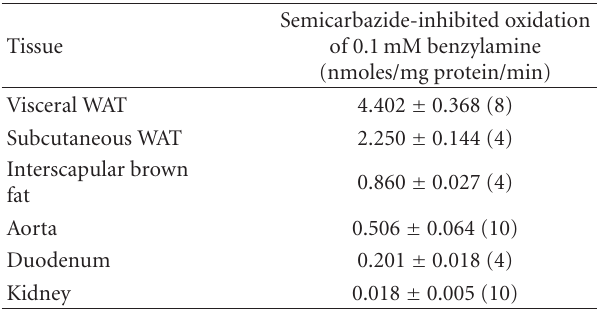
Table 1: Tissue distribution of semicarbazide-sensitive amine oxi- dase activity in control